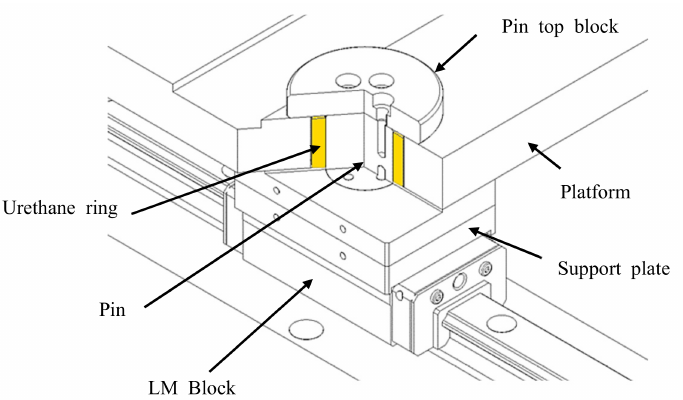
Figure 25. Sectional view of the simply supported blocks in Figure